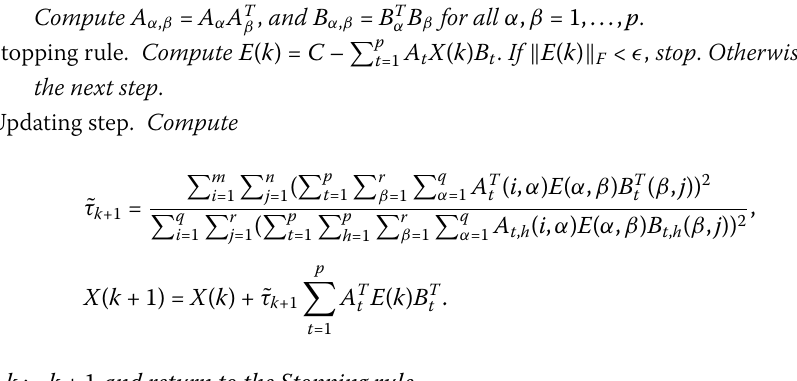
Algorithm 4.1 The gradient-descent iterative algorithm for solving